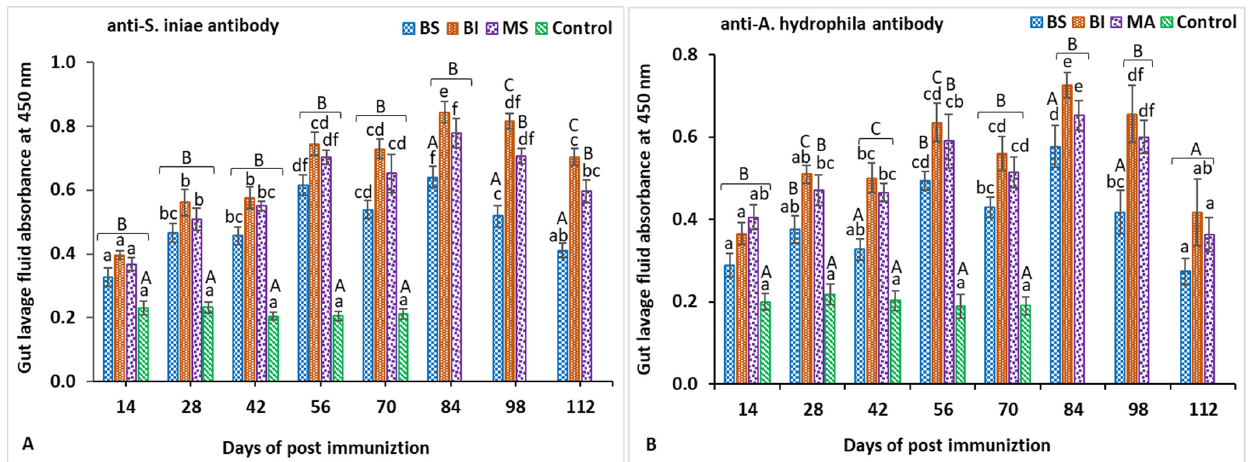
Figure 2. Gut lavage fluid antibody titers against Streptococcus iniae ( A ) and Aeromonas hydrophila ( B ) on different days post-immunization. Data are presented as the mean ± SE of six red tilapia. Statistically significant differences ( p < 0.05) on the same days are denoted by capital letters, whereas significant differences between days are denoted by small letters.